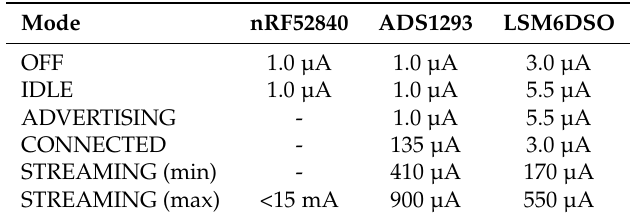
Table 1. Nominal current consumption of the different subsystems in the different operational modes. The microcontroller nominal current in the active states is not indicated because it depends on the running software, see Section 5.4 for actual measured